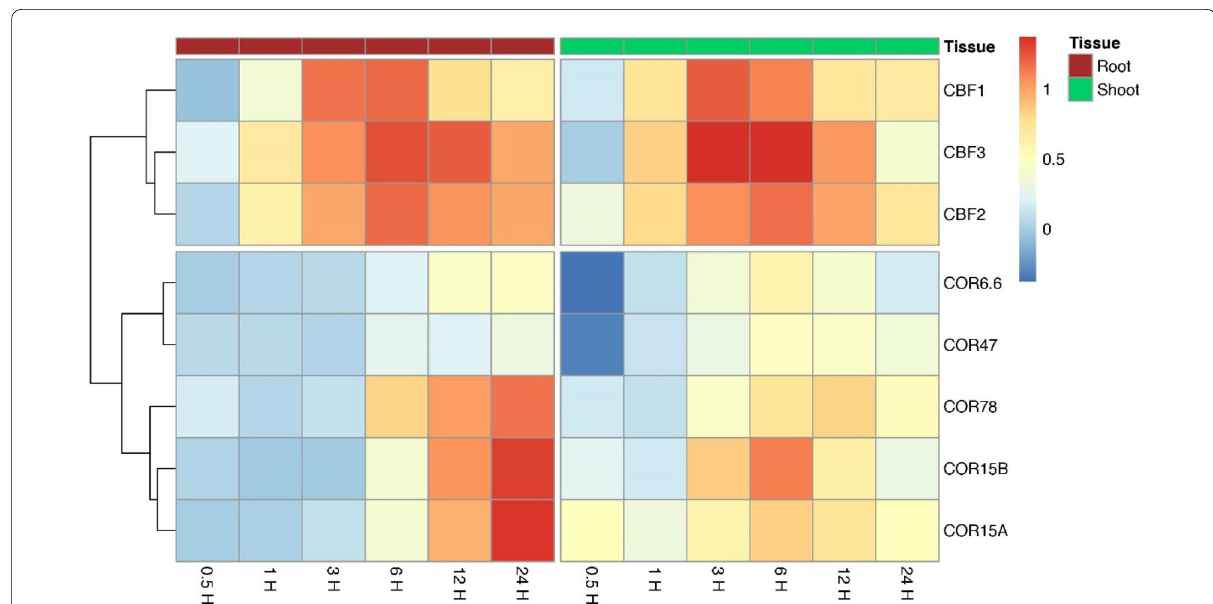
Fig. 6 A heatmap and cluster analysis of the expression fold changes of CBF and COR genes at different time points after cold treatment relative to their corresponding control